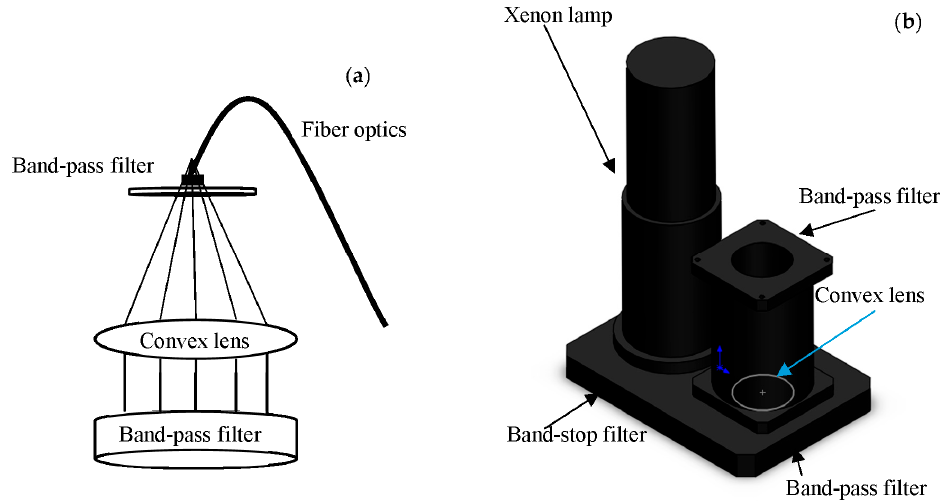
Figure 2. Schematic diagram of the FFS: ( a ) the optical schematic and ( b ) structural sketch of the FFS combined with the continuous wave source.